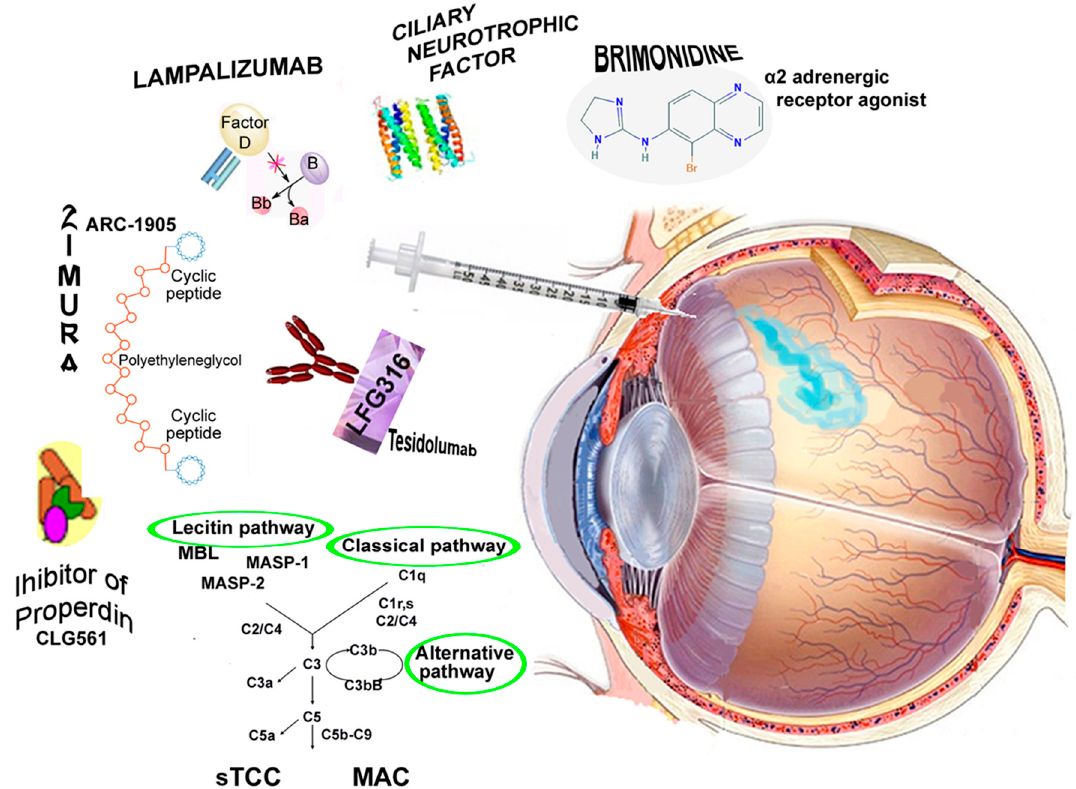
Figure 2. The intravitreal injection (IVI) is a procedure to place a medication directly into the vitreous cavity. IVIs are used to administer medications in various retinal conditions. Representation of molecules, neuroprotective, immunomodulatory or anti-inflammatory agents, which have been used for IVIs in patients with geographic atrophy (GA). MBL: mannose-binding lectin; MASP: MBL-associated serine proteases, MASP-1, and MASP-2; sTCC: soluble terminal complement complex; MAC: membrane attack complex.